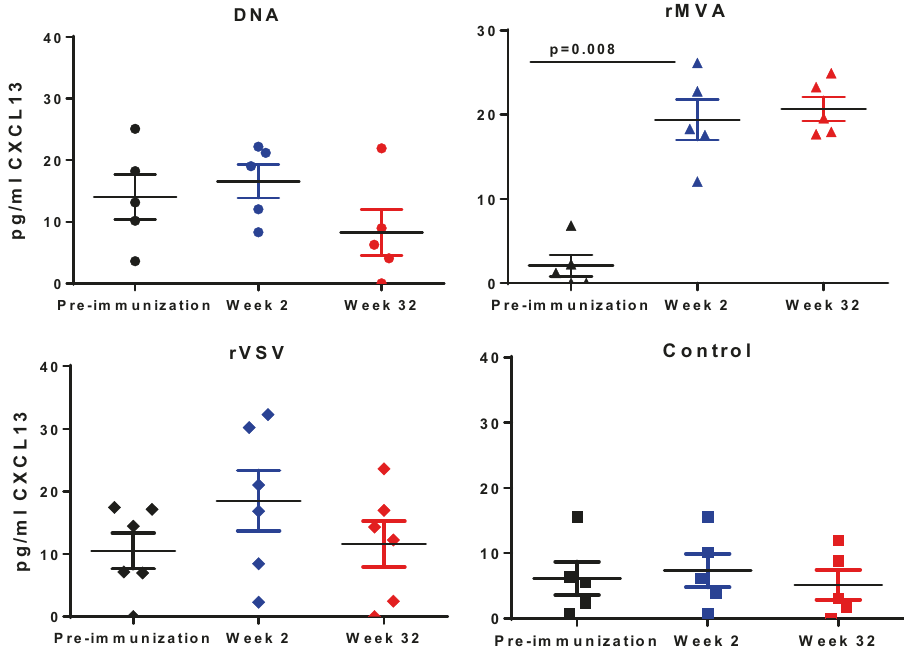
Fig. 5 rMVA prime monkeys have highest CXCL13 levels in their plasma. Plasma samples from pre-immunization (black symbols), Week 2 (blue symbols), and Week 32 (red symbols) from all monkeys in four vaccine groups were assessed for CXCL13 levels by ELISA assay following manufacturer ’ s protocol (R&D Systems). Level of CXCL13 (pg/ml) was derived from the standard curve generated from the OD values at 570 nm. Mean and SEM are shown for each vaccine